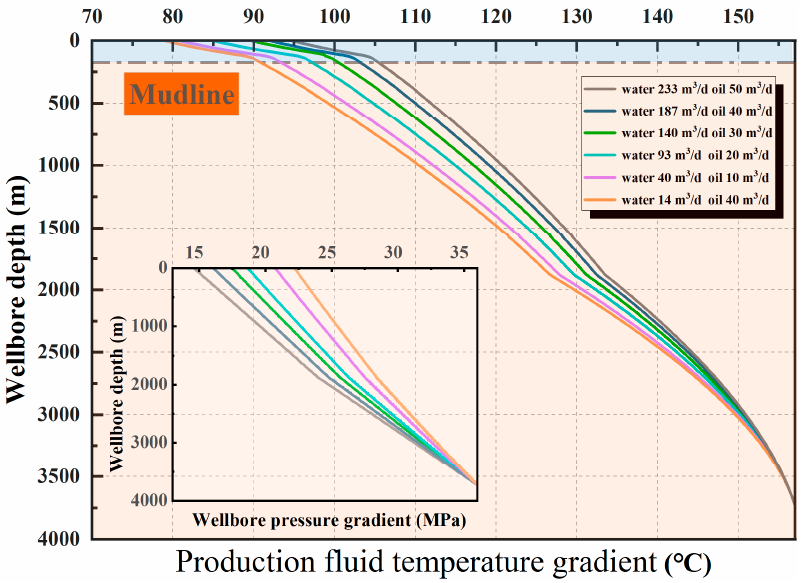
Figure 8. The influence of gas–liquid ratio on wellbore temperature and pressure.